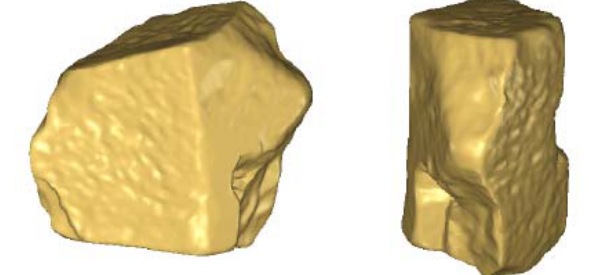
Figure 12: 3D modelling of block n°6 (Face 1) and its PCV rendering.